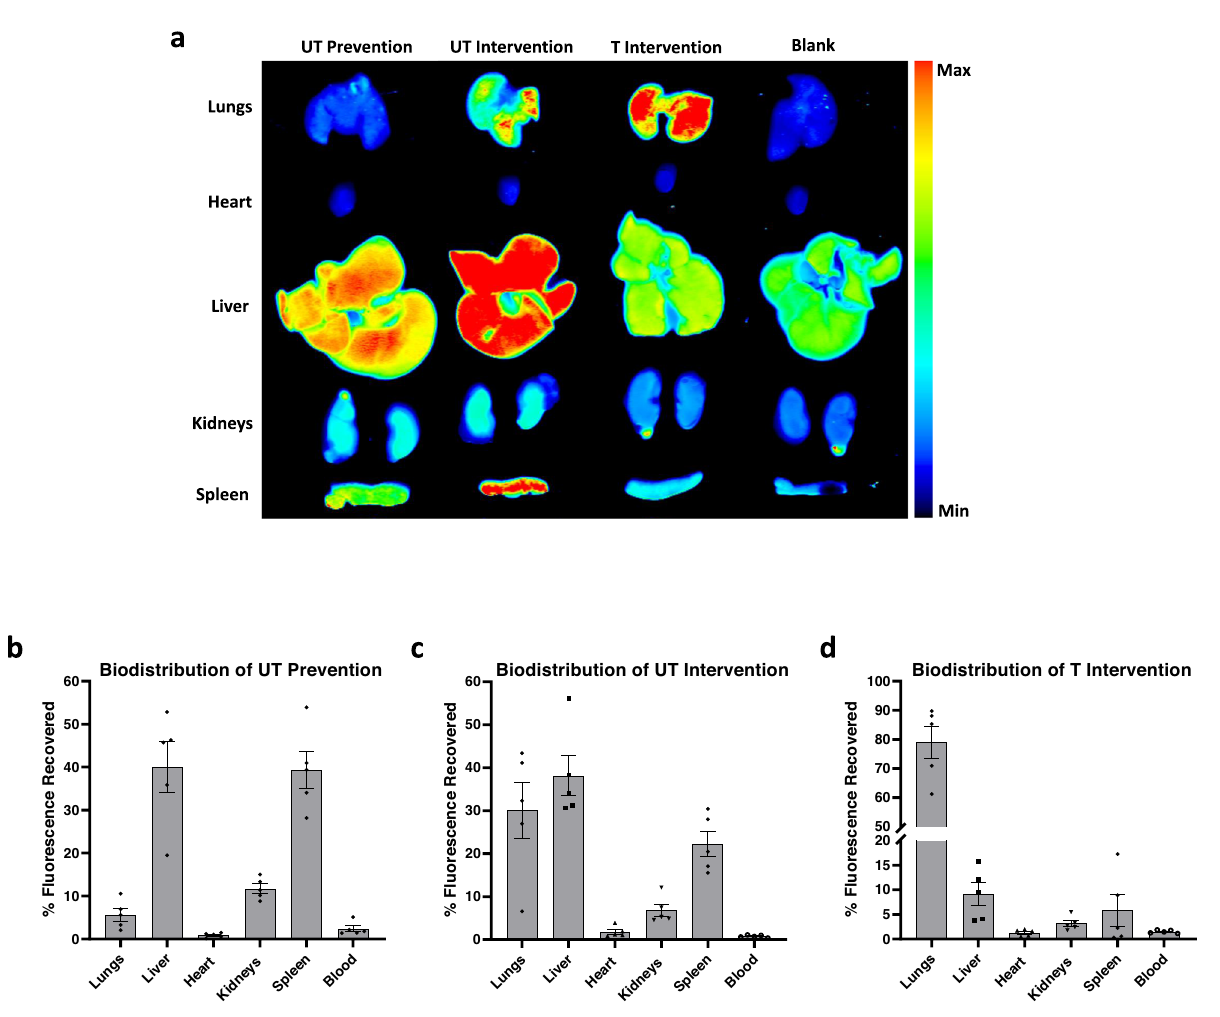
Fig. 5 | Biodistribution of particles in treated mice. a Representative scans of organs treated with particles ( ‘ Untargeted (UT) prevention, ’ ‘ UT intervention, ’ and ‘ Targeted (T) intervention ’ ) and untreated ( ‘ Blank ’ ) mice using an Odyssey CLx InfraredImagingSystemthreehoursaftertreatmentwithLPS.Quanti fi edresultsof recovered fl uorescence in each organ (percent of total fl uorescence recovered